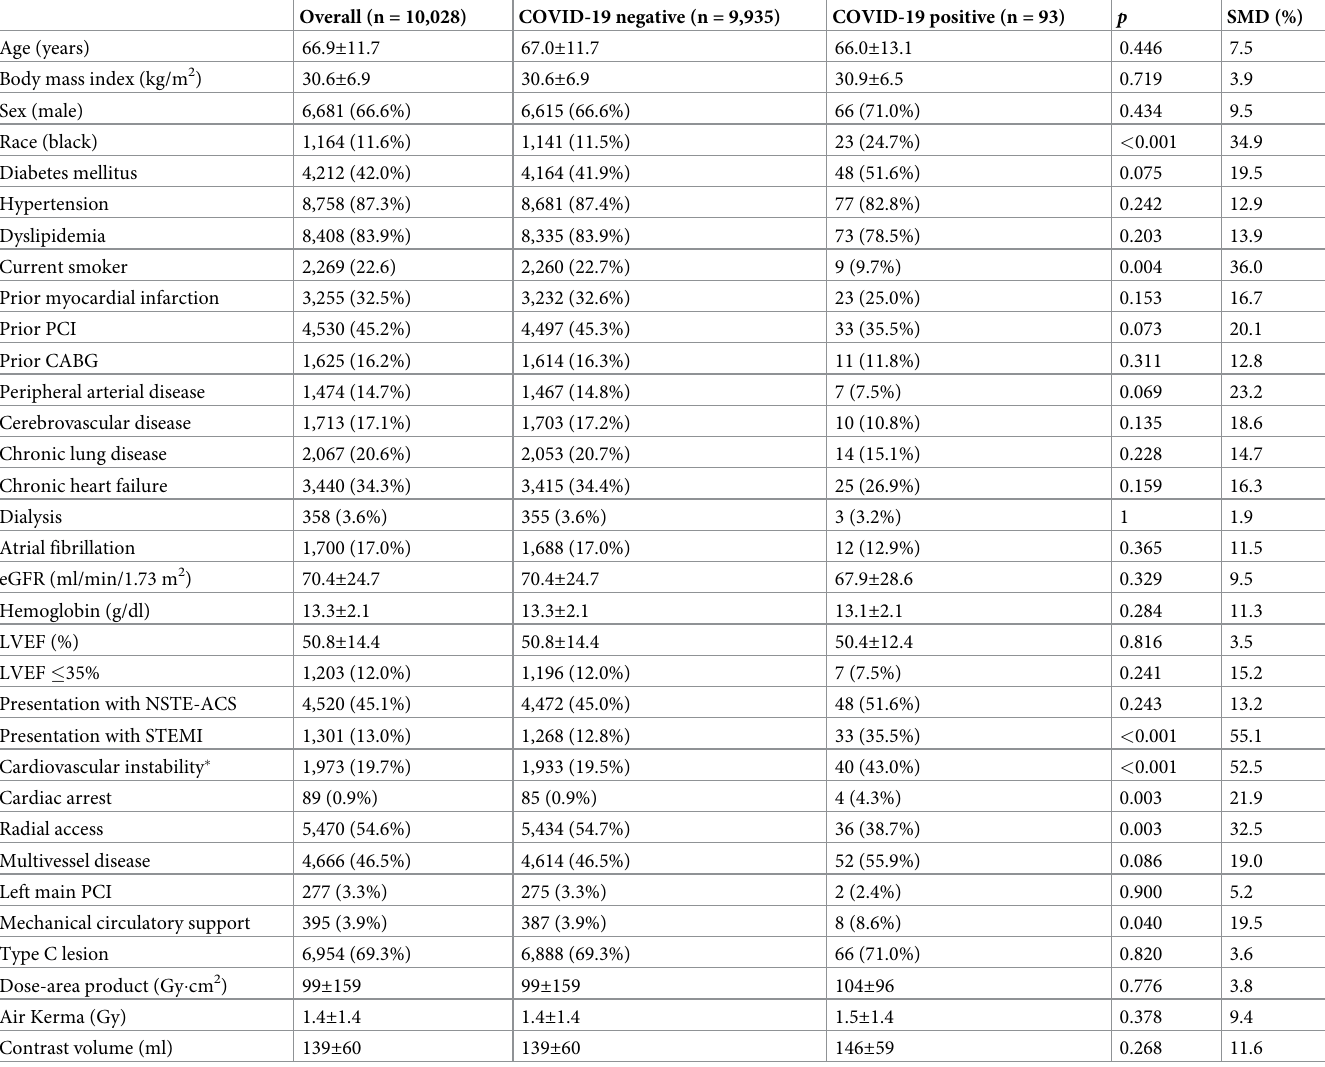
Table 3. Clinical and procedural characteristics in patients with a positive vs. negative COVID-19 test in the pandemic